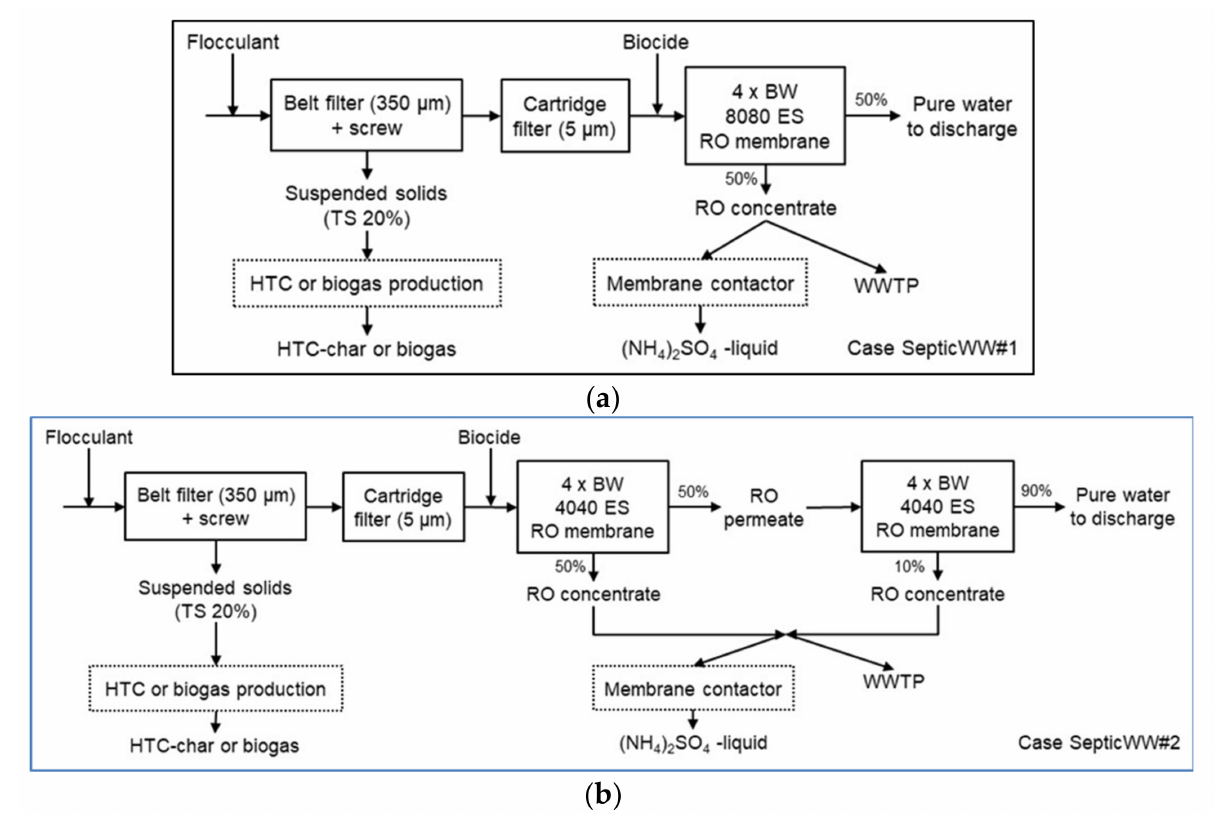
Figure 3. ( a ) Block diagram for cases SepticWW#1 and ( b )